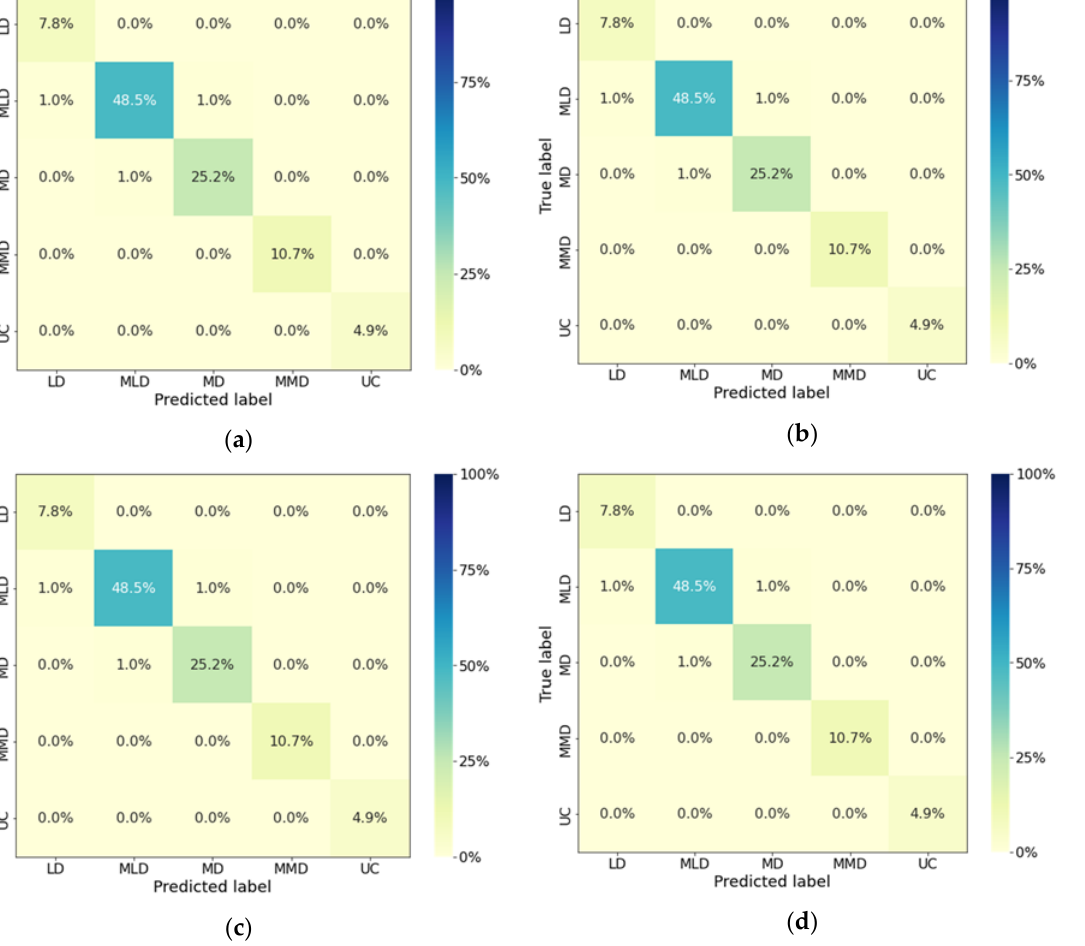
Figure 13. Random forest classified muscle workload for ( a ) gastrocnemius right, ( b ) gastrocnemius left, ( c ) soleus right, ( d ) soleus left. Right muscles: brake operation, left muscles: clutch operation. LD—light discomfort, MLD—more than light discomfort, MD: moderate discomfort, MMD—more than moderate discomfort, UC—uncomfortable.